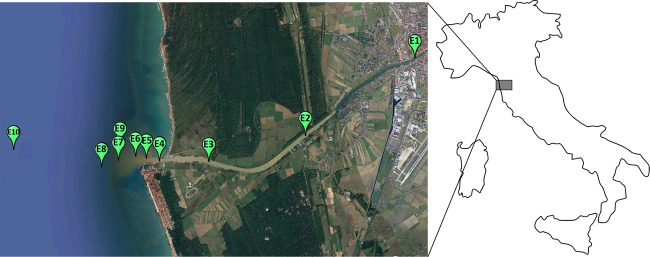
Sampling sites along the Arno River estuary (Pisa, Italy) (image source: Google Earth Pro).